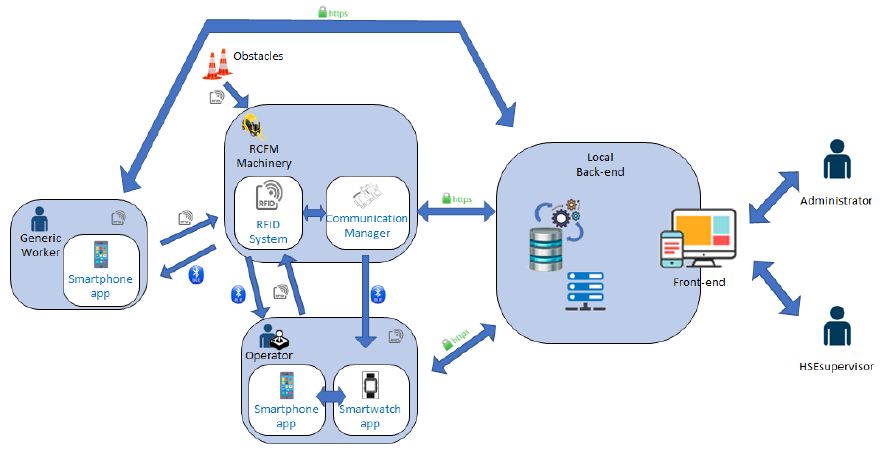
Figure 2. High-level SMARTGRID system